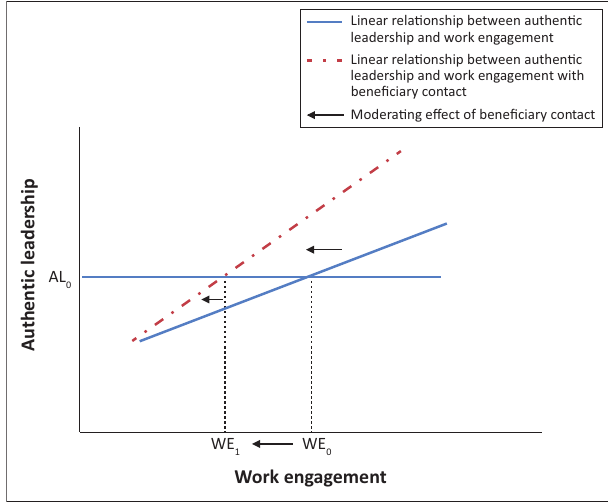
FIGURE 2: Graphical depiction of the moderating effect of beneficiary contact on the impact of authentic leadership on work